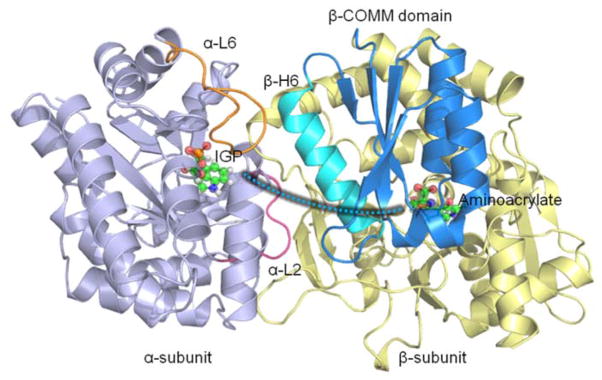
Overall structure and chemical reactions of tryptophan synthase (TRPS). TRPS is composed of an α- (purple) and β-subunit (yellow). The two ligands binding to each subunit are shown in bead representation. The open, partially closed, and fully closed conformations of the α-subunit are controlled by α-L2 (pink), α-L6 (orange), and β-Helix-6 of the COMM domain (cyan). The tunnel used to channel indole from the α-site to the β-site is marked as a cyan dashed shaded line.